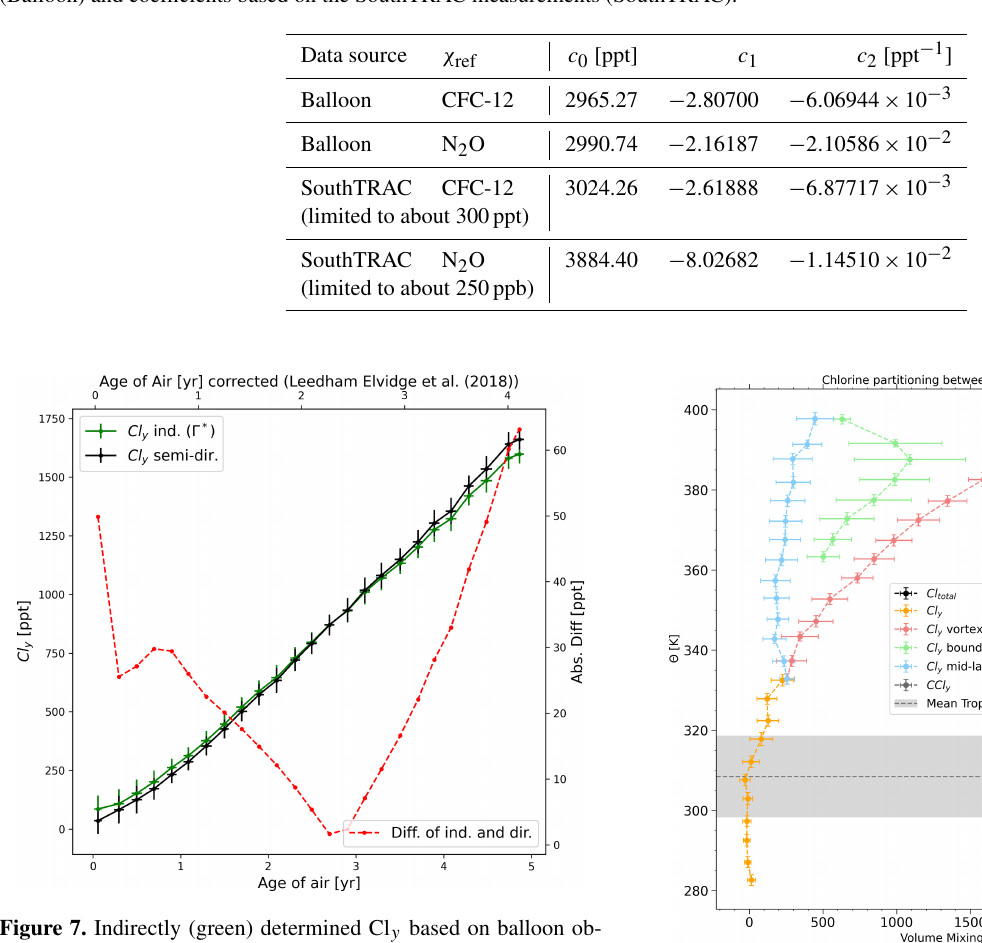
Table 2. Coefficients of the correlation function to indirectly derive Cl y with the respective reference substance for the time of the South- TRAC campaign (2019.75). Calculation of Cl y with CFC-12 or N 2 O and coefficients based on the balloon observations in 2009 and 2011 (Balloon) and coefficients based on the SouthTRAC measurements (SouthTRAC).